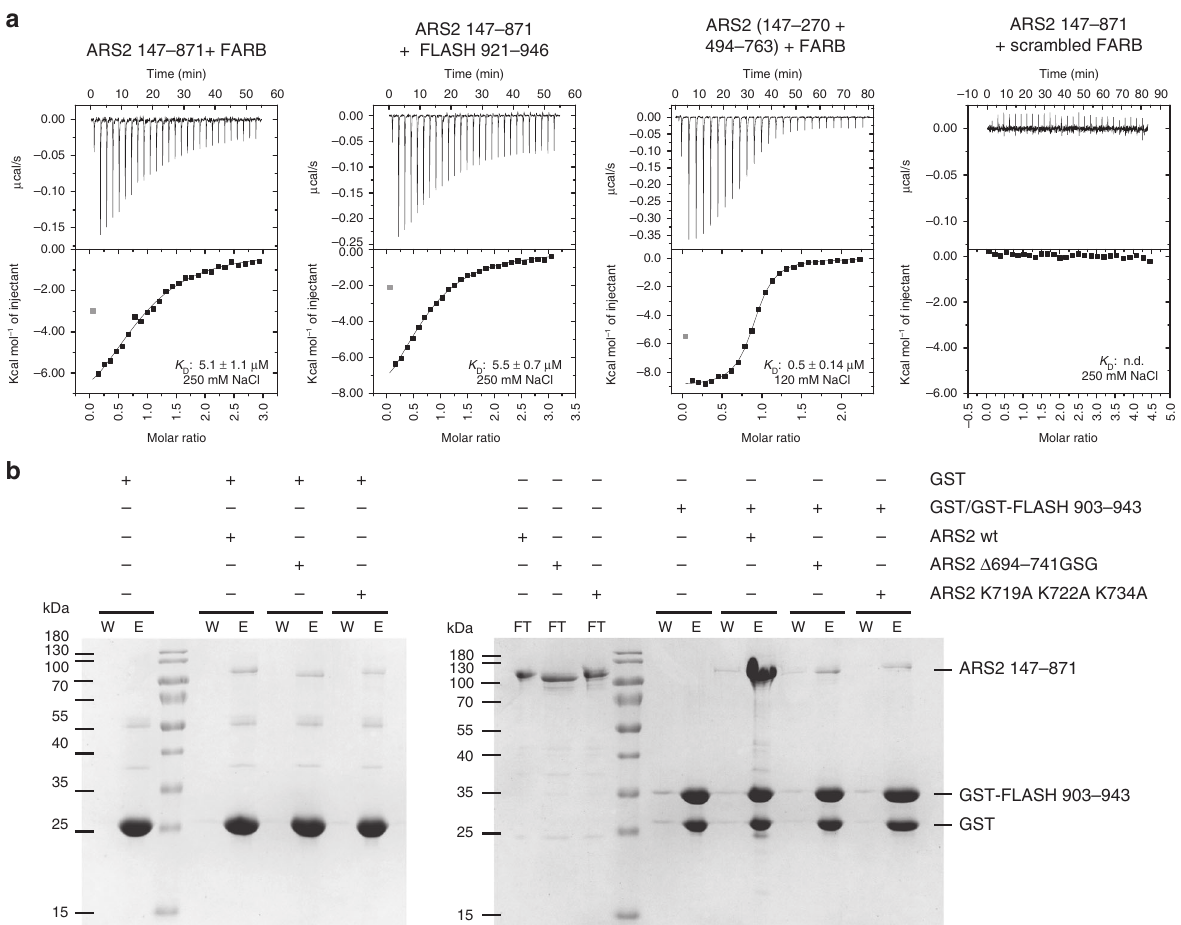
Fig. 4 The FARB peptide of FLASH binds to the ARS2 C-terminal leg. a Isothermal calorimetry data for different ARS2 constructs and FLASH peptides. The upper graphs show the raw data and the bottom graphs show the ligand concentration dependence of the heat released upon binding after normalisation. K D values represent the average from at least two independent experiments (Table 2). b GST pull down of GST constructs. GST – FLASH 903 – 943 or GST as control was immobilised on glutathione resin followed by incubation with different ARS2 constructs. The fl ow- though (FT), last wash (W) and elution (E) fractions were analysed by Coomassie-stained